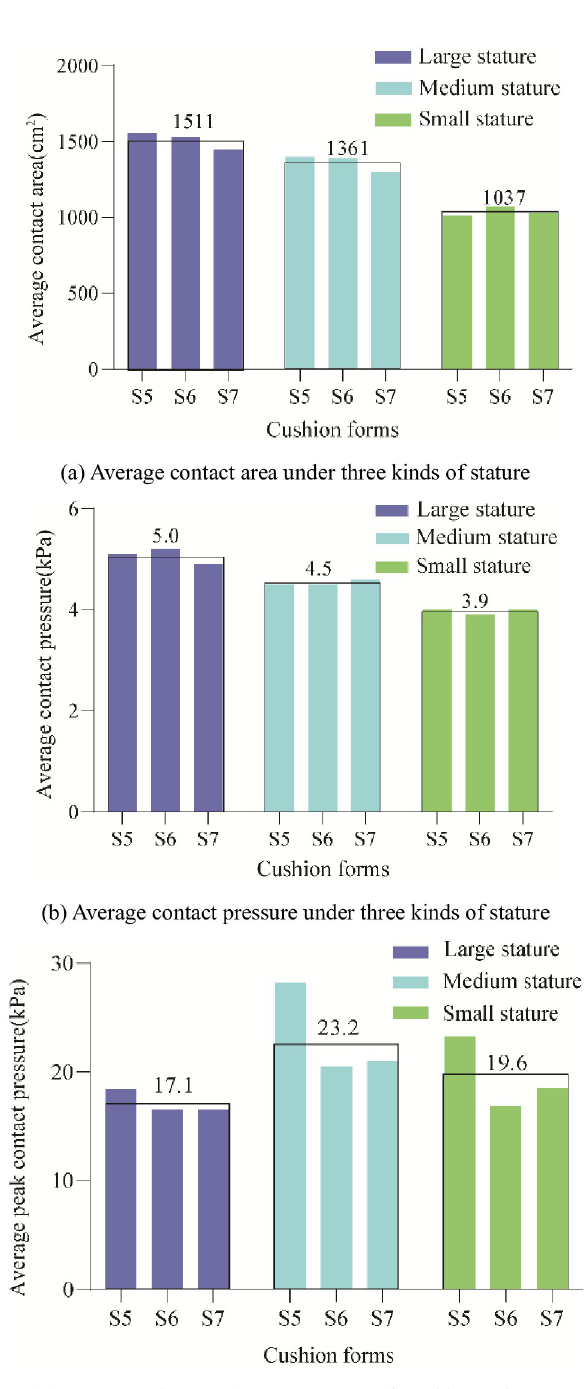
Fig 15. Statistical histogram of pressure distribution parameters of wrapped cushion under three kinds of stature. (a) Average contact area under three kinds of stature, (b) Average contact pressure under three kinds of stature, and (c) Average peak contact pressure under three kinds of